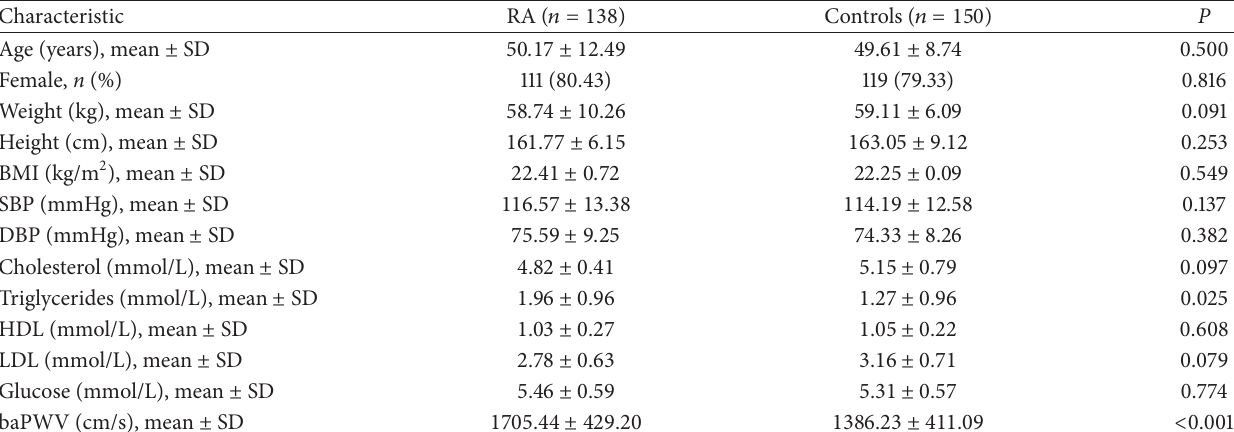
Table 1: Clinical characteristics of patients and controls.